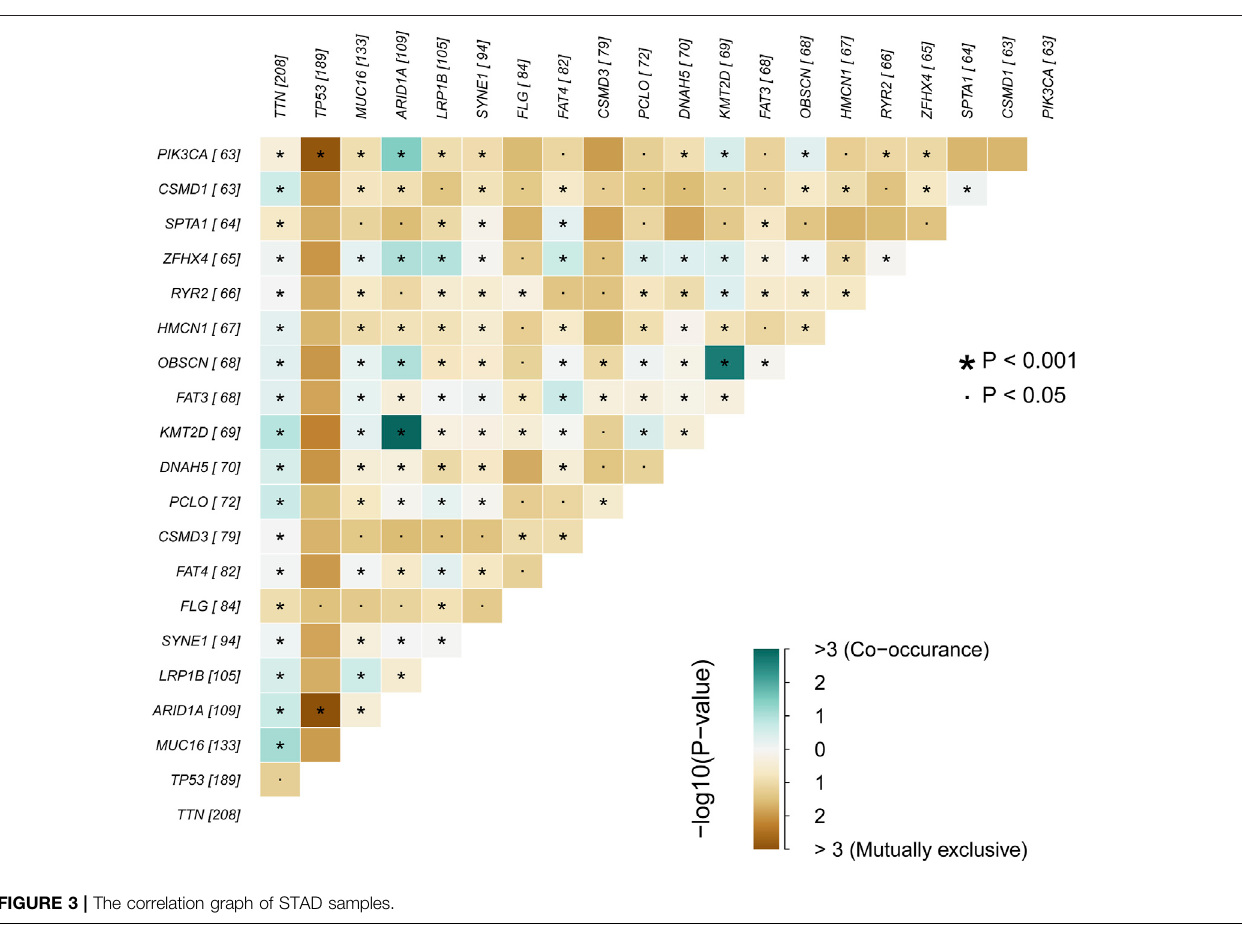
Frontiers in Cell and Developmental Biology |